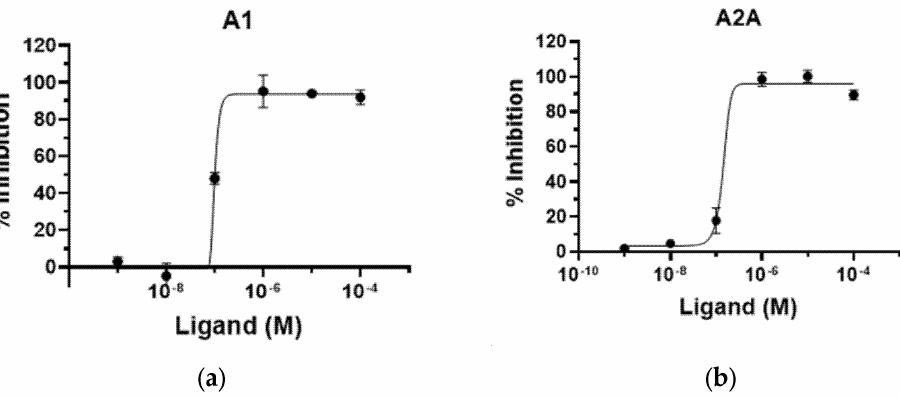
Figure 3. Functional activity of compound 11o toward human adenosine receptors. ( a ) A 1 receptor in CHO–K1 cell. ( b ) A 2A receptor in HEK–293